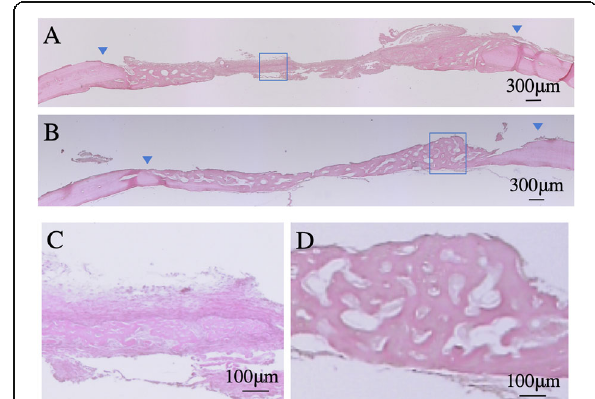
Fig. 5 Histological images of decalcified sections stained with hematoxylin-eosin at 2 weeks. a In the control. b In the test. Blue arrows show the original defect margins. c High magnification image of in flamed area in the control. d High magnification image of in flamed area in the test. The center of the sample was